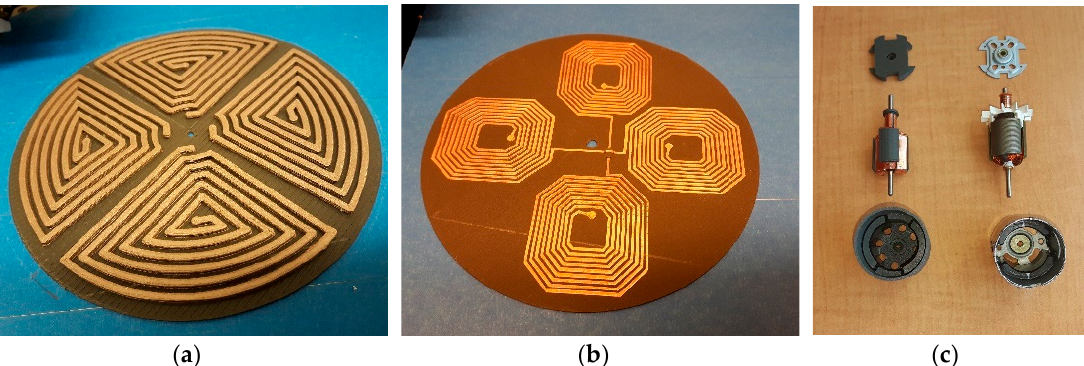
Figure 6. ( a ) 3D printed pancake motor rotor comprised of a Proto-Pasta disk with Virtual Foundry wiring; ( b ) LOM-based adhesive-backed copper tape on the 3D-printed rotor; ( c ) 3D-printed motor assembly with LOM-based coils with a commercial off-the-shelf motor assembly for direct performance benchmarking.